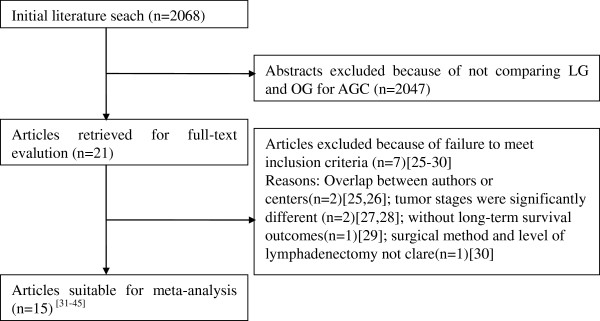
Flow chart of literature search strategies.